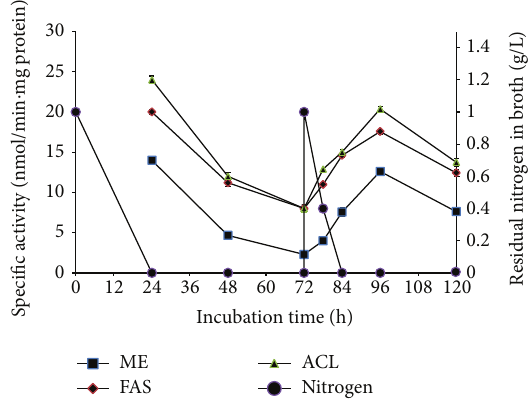
Figure 3: Effect of feeding ammonium tartrate at 72 hours of cultivation on ME, FAS, and ACL specific activities of C. bainieri 2A1. The culture was cultivated in 500 mL shake flask containing 200 mL of nitrogen-limited medium at 30 ∘ C, 200 rpm, and starting inoculums of 10% (v/v). The data represent means ± SDs, 𝑛 = 3 .